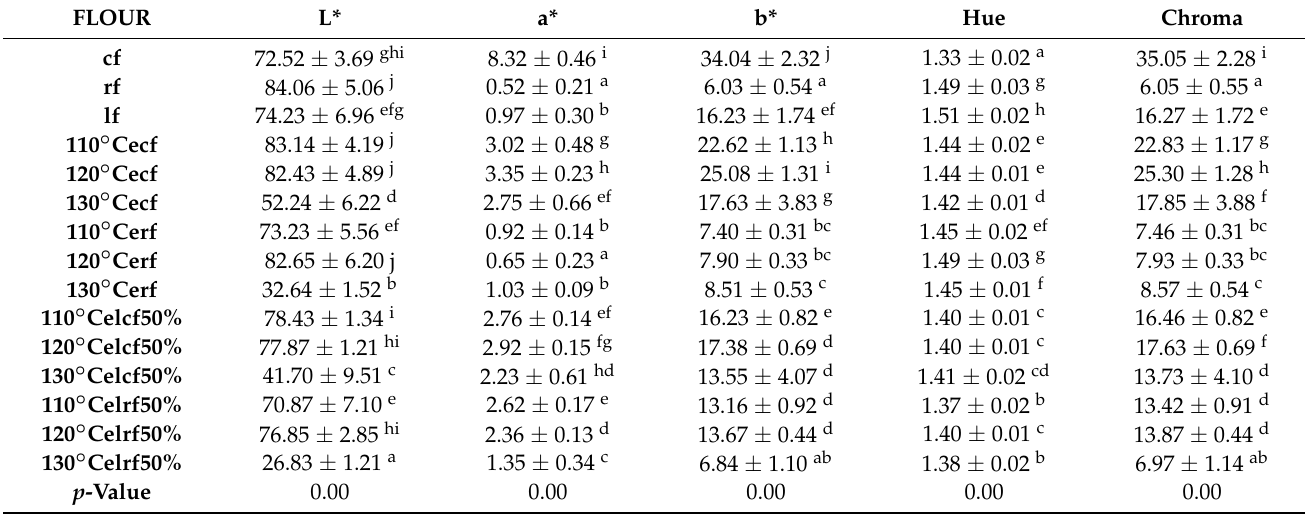
Table 2. Colorimetric parameters (CIE L* a* b*, hue and chroma) of native and extruded flours.